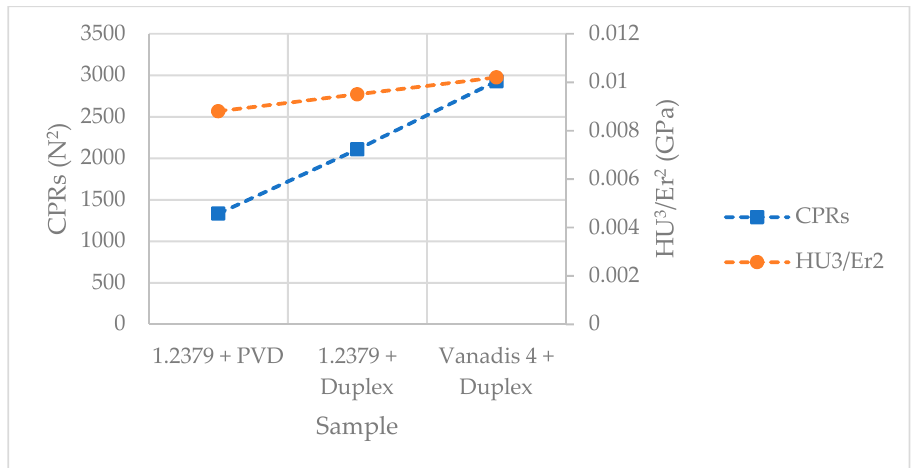
Figure 7. CPR and HU 3 /Er 2 values for each coated sample (1.2379 + PVD, Duplex + 1.2379, and Duplex + Vanadis 4).